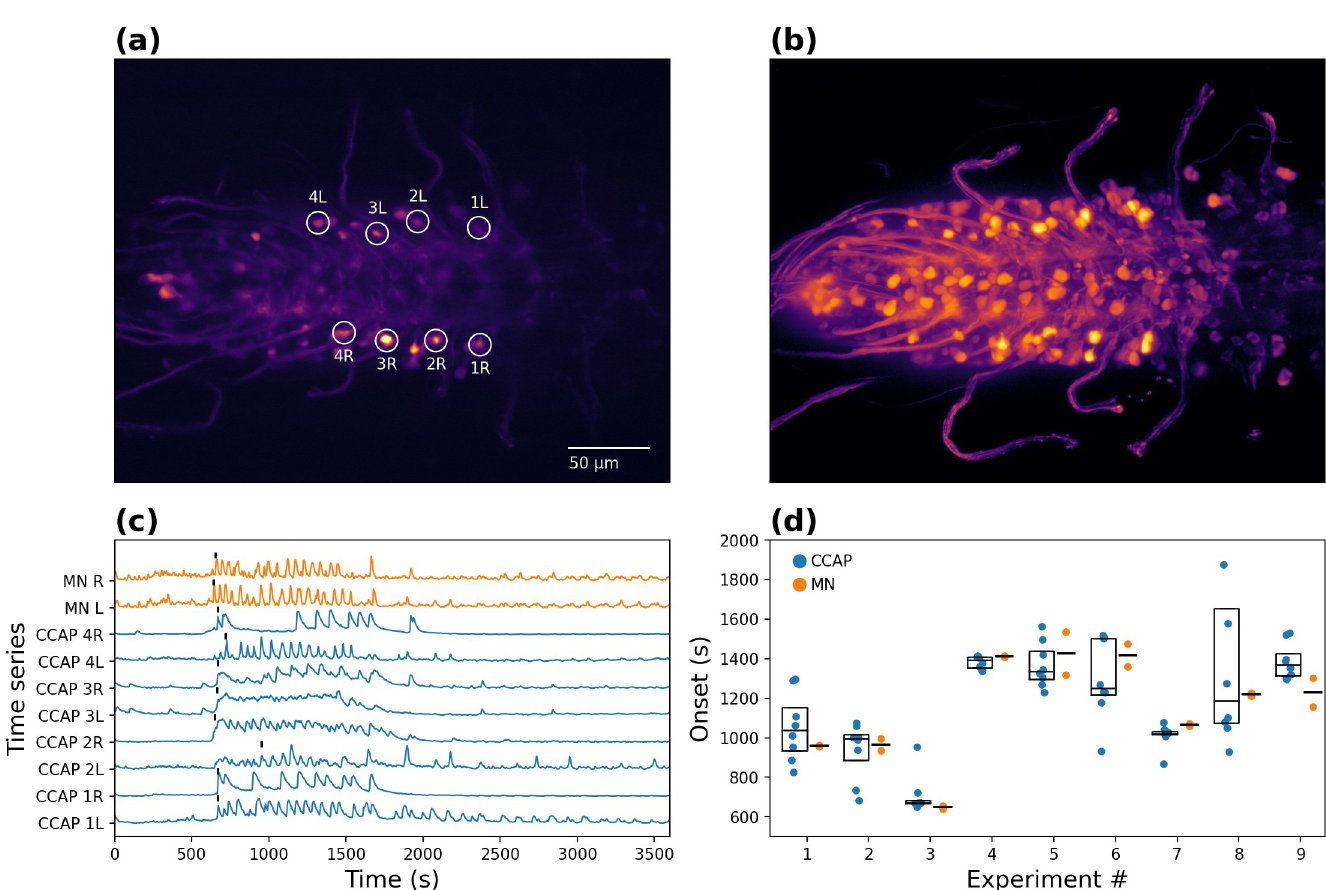
Fig 1. CCAP neuron and motoneuron activity. (a) Single-plane calcium imaging of GCaMP3.2-expressing CCAP neurons. (b) Projection of 5 images from different planes, of GCaMP3.2-expressing CCAP neurons and motoneurons. The same scale bar from panel (a) applies. (c) Time series of signals from calcium sensor in AN1-AN4 α CCAP neurons and motoneurons recorded in a single experiment; time zero corresponds to moment of ETH-stimulation. The letter indicates the side (left [L] and right [R]), while the number indicates the abdominal segment of the neurons. Vertical marks denote the onset of oscillatory activity, as detected by the procedure indicated in Methods. (d) Mean time of onset of α CCAP neuron and motoneuron activity, for each of 9 separate experiments, showing temporally close values between populations. “MN” and “CCAP” indicate motoneurons and α CCAP neurons, respectively. Each MN-CCAP pair corresponds to a single experiment, with its 2 MN and 8 CCAP recordings. Box plots indicate intra-experiment median and